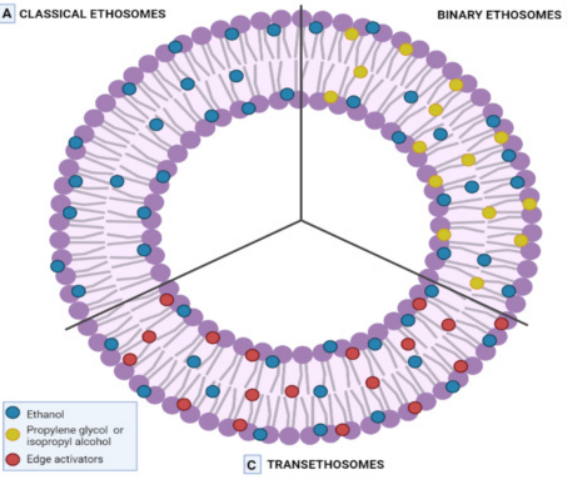
Figure 5. Structural representation of ethosomes: classical ethosomes ( A ), binary ethosomes ( B ), and transethosomes ( C ). Created with BioRender.com (accessed on 10 January 2022). Binary ethosomes are formulated not only with ethanol but also with propylene glycol (PEG) and isopropyl alcohol. The last two offer improved stability and permeation proprieties due to their higher hygroscopicity and viscosity. Moreover, this new type of binary ethosome is able to carry an increased amount of drugs into the deeper layers of the skin